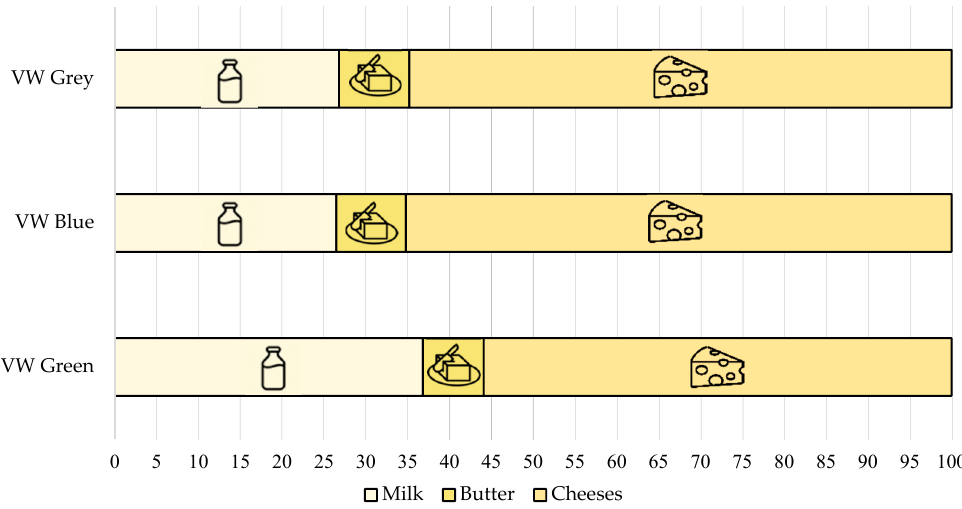
Figure 5. Percentage composition of virtual water of the main categories of dairy products. Cheese contributed greatly even to the grey VW of the Trentino Alto Adige dairy system, followed by milk. The grey component provides an indication of the level of pollution generated during the production process. In the case of the dairy supply chain, the increase in the grey water component is mainly due to animal waste, use of fertilizers and pesticides for forage crops, and sediments from eroded pastures